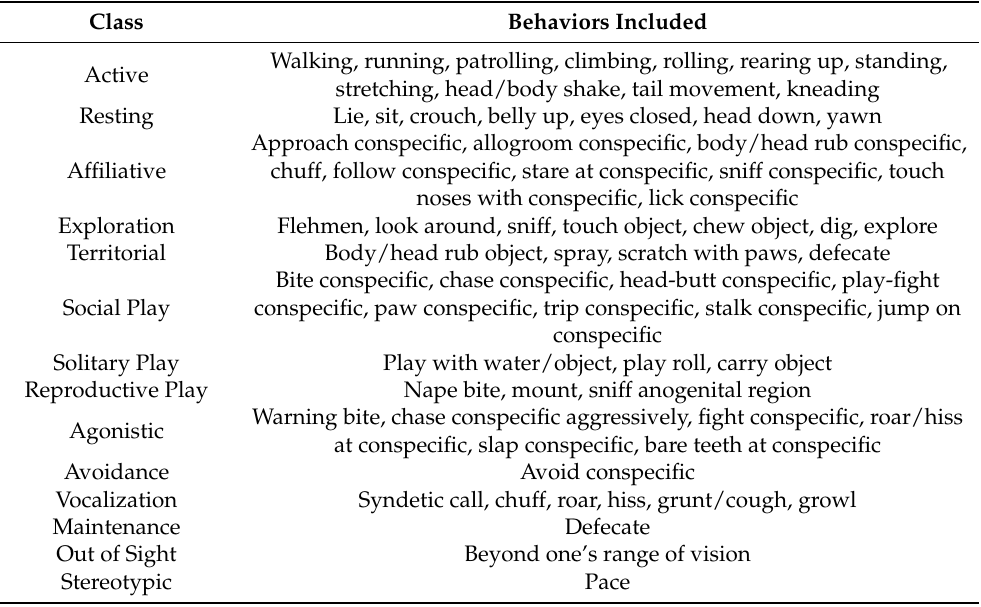
Table 2. Behavioral classes categorized in order to create time budgets. Individual behaviors selected come from the selected ethogram in Appendix